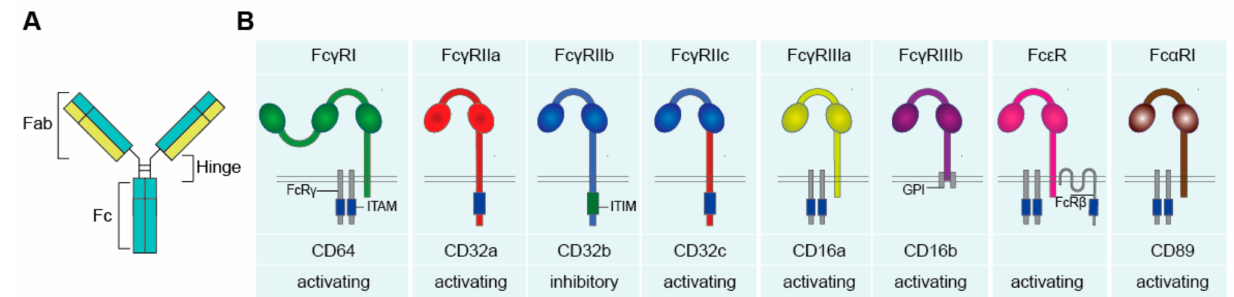
Figure 1. The human Fc receptors for IgG (Fc γ R), IgA (Fc α R), and IgE (Fc ε R). ( A ) Schematic figure of an antibody, comprising of two Fab and one Fc region, connected via the hinge region. ( B ) Fc receptors recognize antibodies upon binding of the Fc tail to the extracellular Ig-like domains. Upon activation, FcRs can induce activating and inhibitory downstream signaling, mediated via ITAM and ITIM motives. Abbreviations: Fab, fragment antigen binding; Fc, fragment crystallizable; Ig, immunoglobulins; ITAM, immunoreceptor tyrosine-based activating motif; FcR γ , FcR gamma chain; ITIM, immunoreceptor tyrosine-based inhibitory motif; GPI, glycosylphosphatidylinositol; FcR β , FcR beta